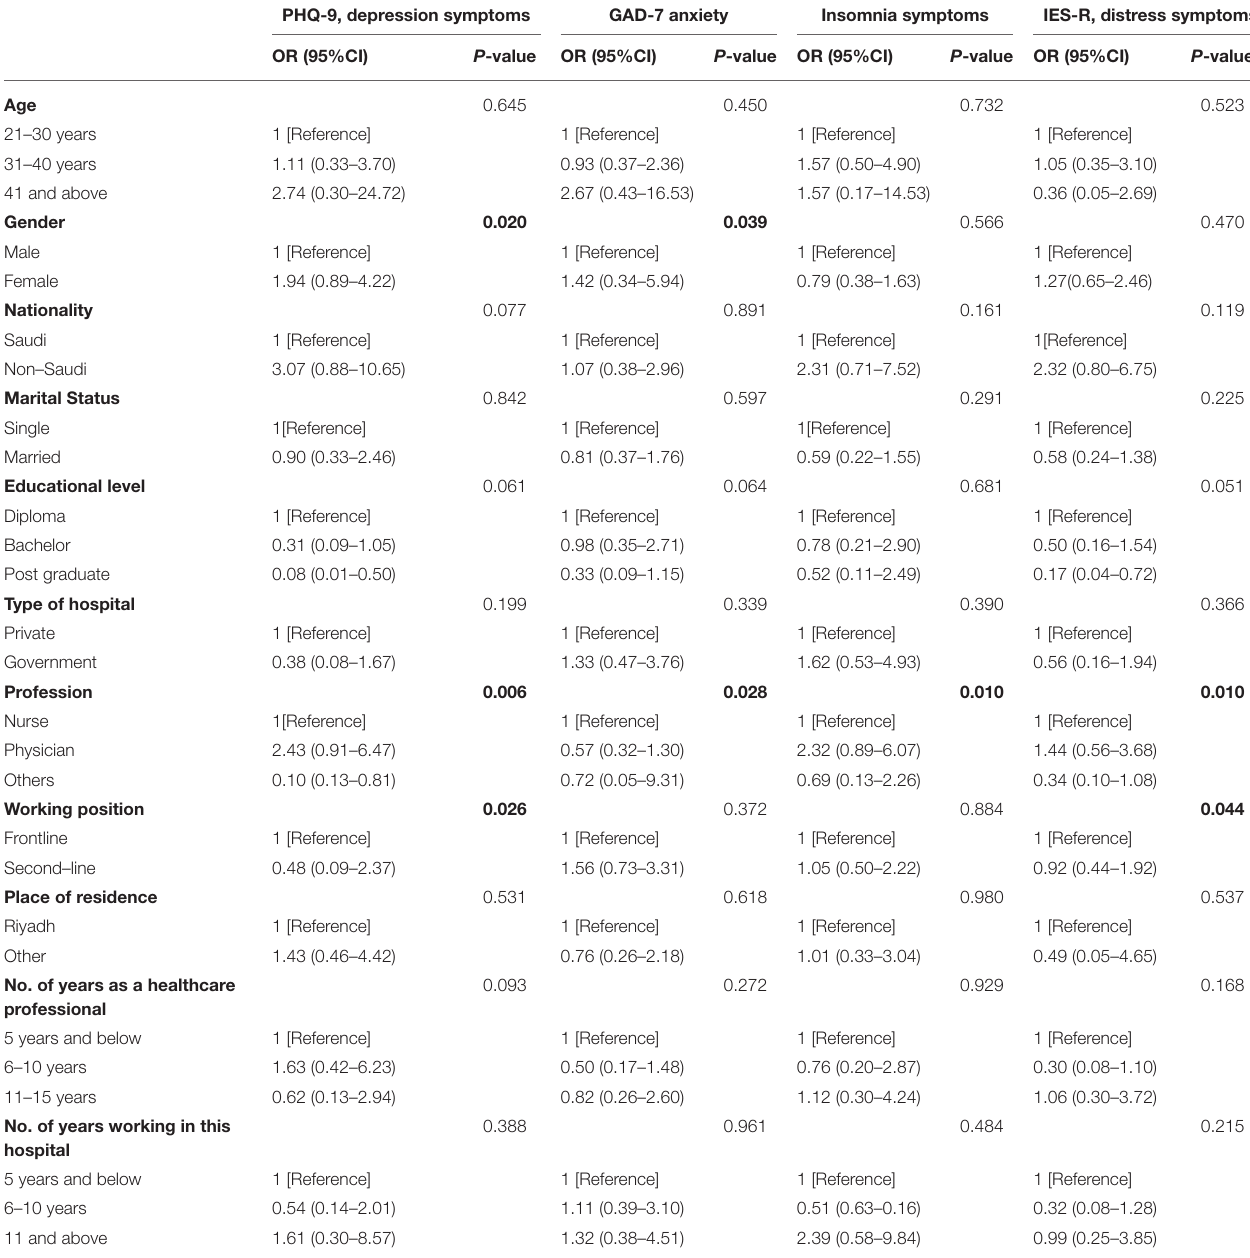
TABLE 3 | Predictors associated for mental health outcomes identified by multivariable logistic regression